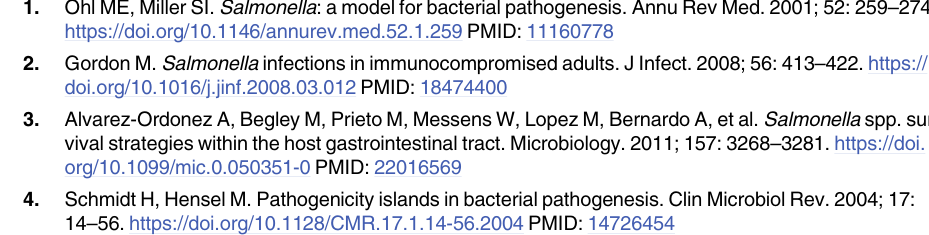
S8 Fig. Representative control experiment for loading normalization of secreted extracts. A. Coomassie stained SDS-PAGE of either cell extracts (upper panel) or secreted protein extracts (lower panel) from two cultures of the strains SV5015 (WT) and TGC3 ( Δ greA Δ greB ) grown in LB at 37˚C up to an OD of 2.0. Lane M: molecular mass markers (size in kDa 600nm indicated). B. Immunodetection of CRP, a cytoplasmic protein, in the indicated extracts from the same cultures as in A. (PDF) S1 Table. Strains and plasmids used in this study. (PDF) S2 Table. Primers used in this study.